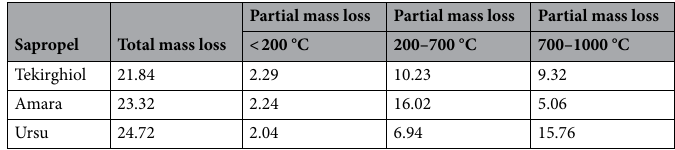
Table 3. Mass loss determined by thermogravimetric analysis of sapropel samples.